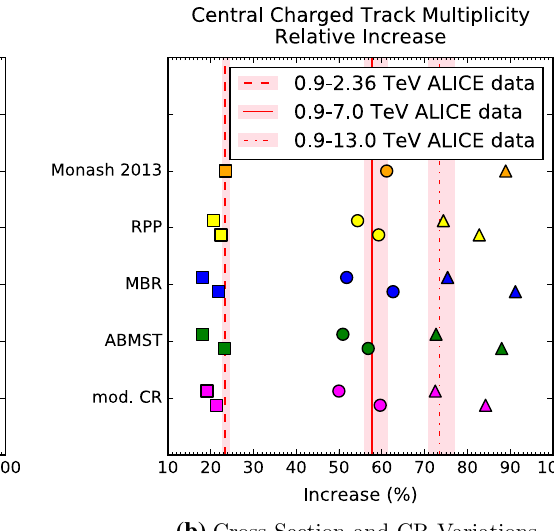
( a ) PDF Variations (+ PHOJET) (b) Cross-Section and CR Variations colour reconnections. For comparison, the predictions for PHOJET Fig. 4 The relative increase in the number density of charged tracks [58] originally included in [56] are also shown in a. In all cases, between 0.9–2.36TeV and 0.9–7TeV measured by ALICE [56] and where two points are shown, these reflect two choices for the parameter updated to include 13TeV data [57]. This observable was used to MultipartonInteractions:ecmPow , with the lower point cor- tune to MultipartonInteractions:ecmPow for variants of responding to the minimum value and the upper point corresponding to the Monash 2013 tune with a alternative choice for the PDF, and the maximum value b different choices for the modelling of the total cross section and